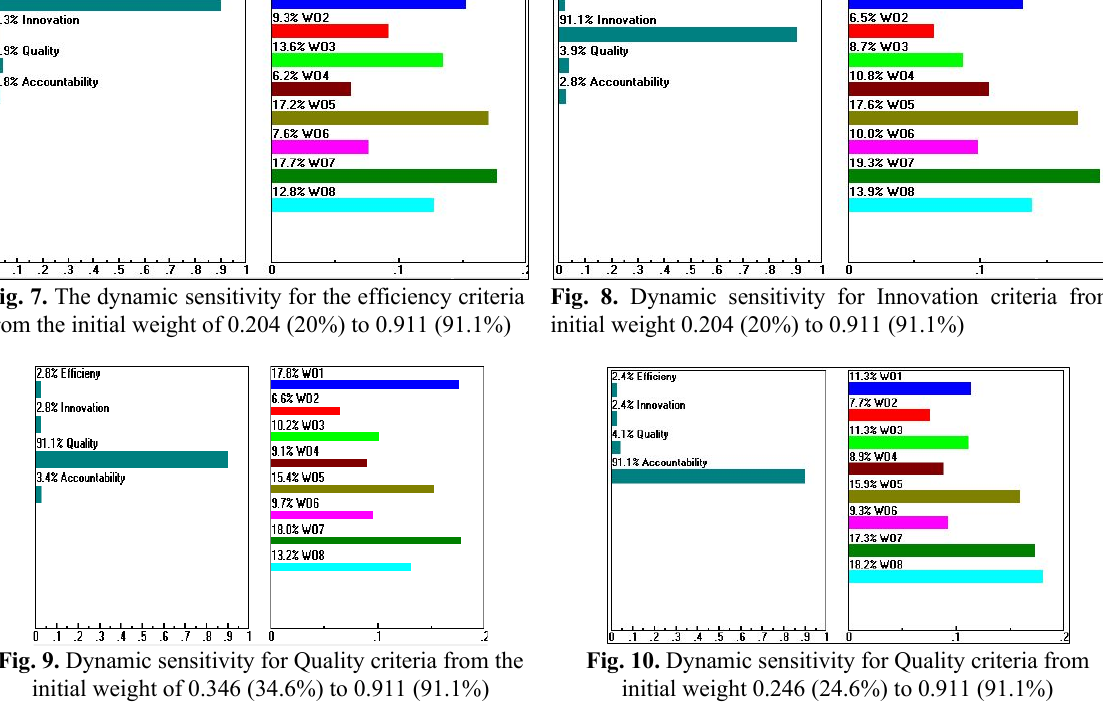
Fig. 9. Dynamic sensitivity for Quality criteria from the initial weight of 0.346 (34.6%) to 0.911 (91.1%)